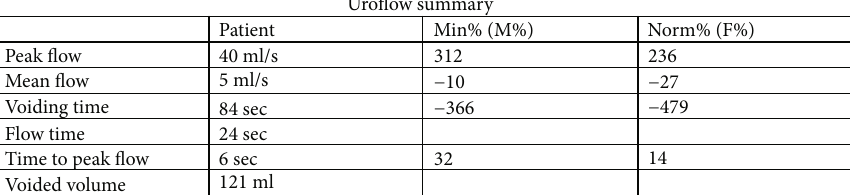
Figure 3: Postoperative urodynamic